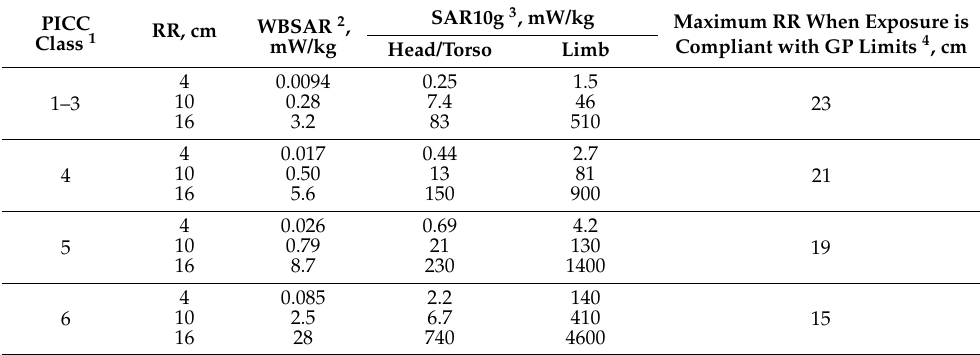
Table 5. SAR values in the model of a person validating a public transport card in an exposure scenario with two people near an HF RFID reader (at 13.56 MHz) with an internal antenna with inner dimensions of 8 × 8 cm, assuming that the RR of considered reader is 4, 10 or 16 cm (according to ISO/IEC 14443-2:2020 requirements for PICCs of various classes).